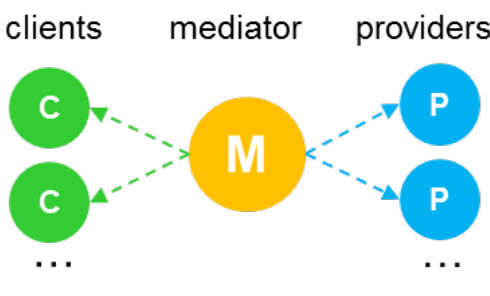
Figure 1: Concept of clients, mediator and